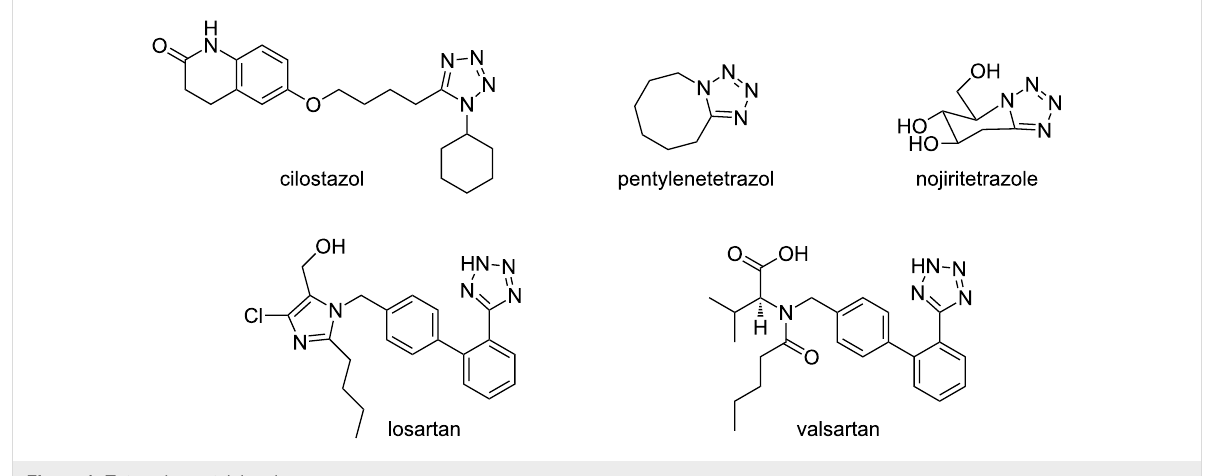
Figure 1: Tetrazole-containing drugs.